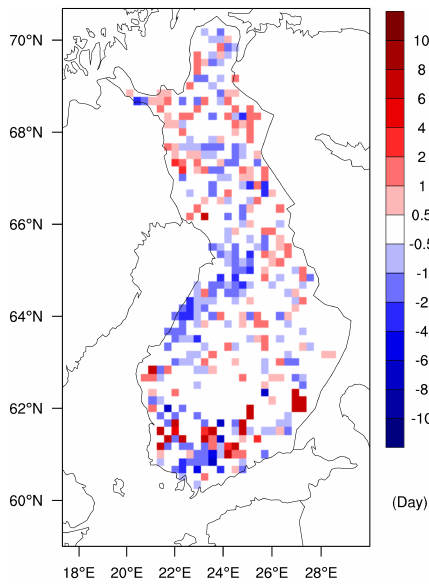
Figure 4. The 15-year averaged differences (FNFI10–FNFI1) in the snow clearance days over model grid boxes in